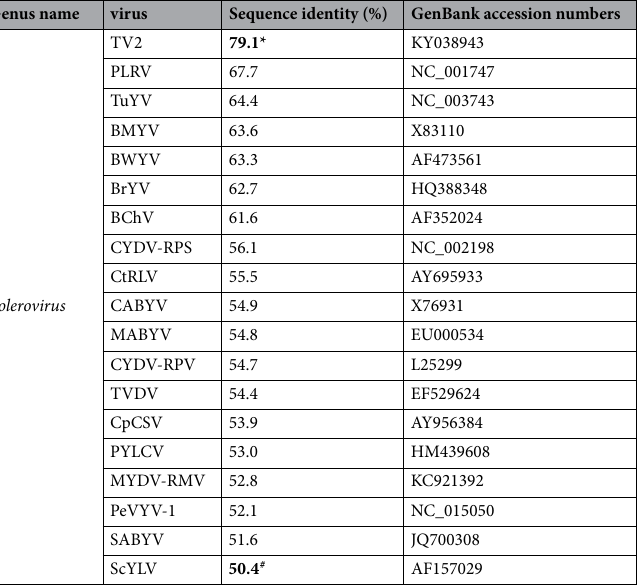
Table 2. Nucleotide sequence comparisons using the nearly full-length genomic sequences of TPV1 with that of other poleroviruses . The bold in the table represent the highest and lowest identities individuals. *The virus shares the highest sequence identity with TPV1; # the virus shares the lowest sequence identity with